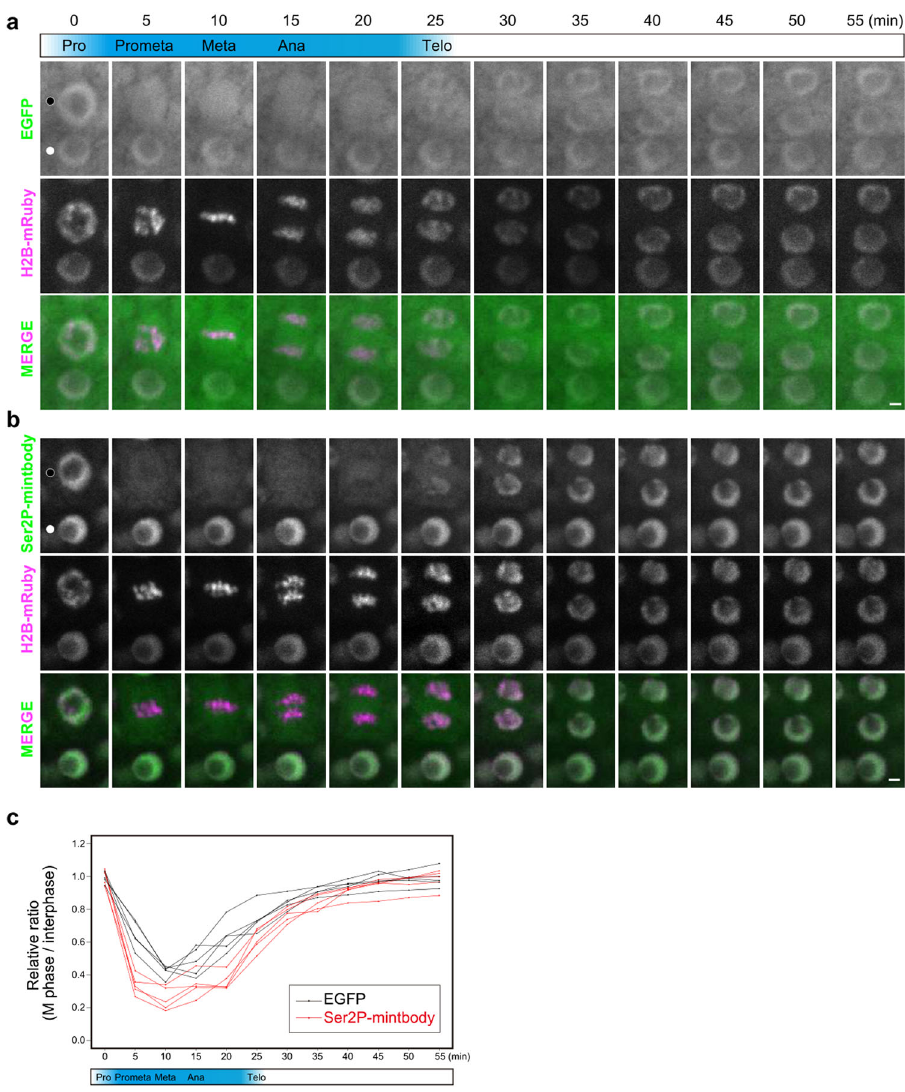
Fig. 5 Dynamics of general transcription activity during the M phase. a , b Time-lapse imaging of the set of EGFP and H2B-mRuby ( a ), and Ser2P- mintbody and H2B-mRuby ( b ) in cortex cells in the root meristematic zone. Representative images of M-phase nuclei ( fi lled circles) and interphase nuclei (open circles) are shown. Images are sum slices of Z-stacks. Scale bars, 2 µ m. c Dynamics of Ser2P level during the M phase. The EGFP or Ser2P-mintbody/ H2B-mRuby intensity ratios in M-phase nuclei and those of interphase nuclei located near the M-phase nuclei were calculated and M phase/interphase ratios are plotted. Source data underlying the plot are available as Supplementary Data